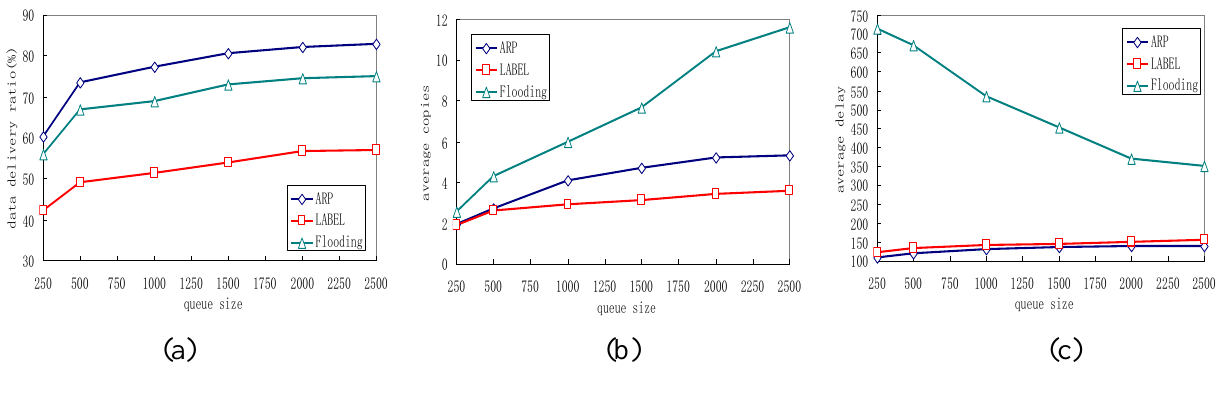
Figure 9. Impact of queue length: (a) Average delivery ratio; (b) Average copies; (c) Average delay.